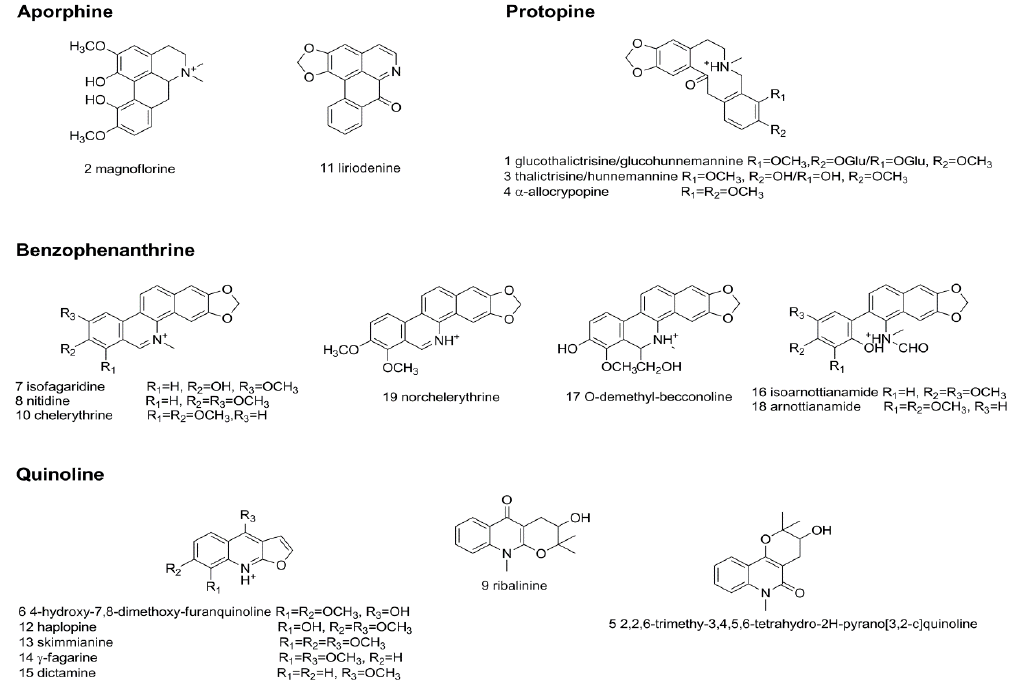
Figure 2. Chemical structure of the alkaloids in rat plasma after oral administration of Z. nitidum decoction.